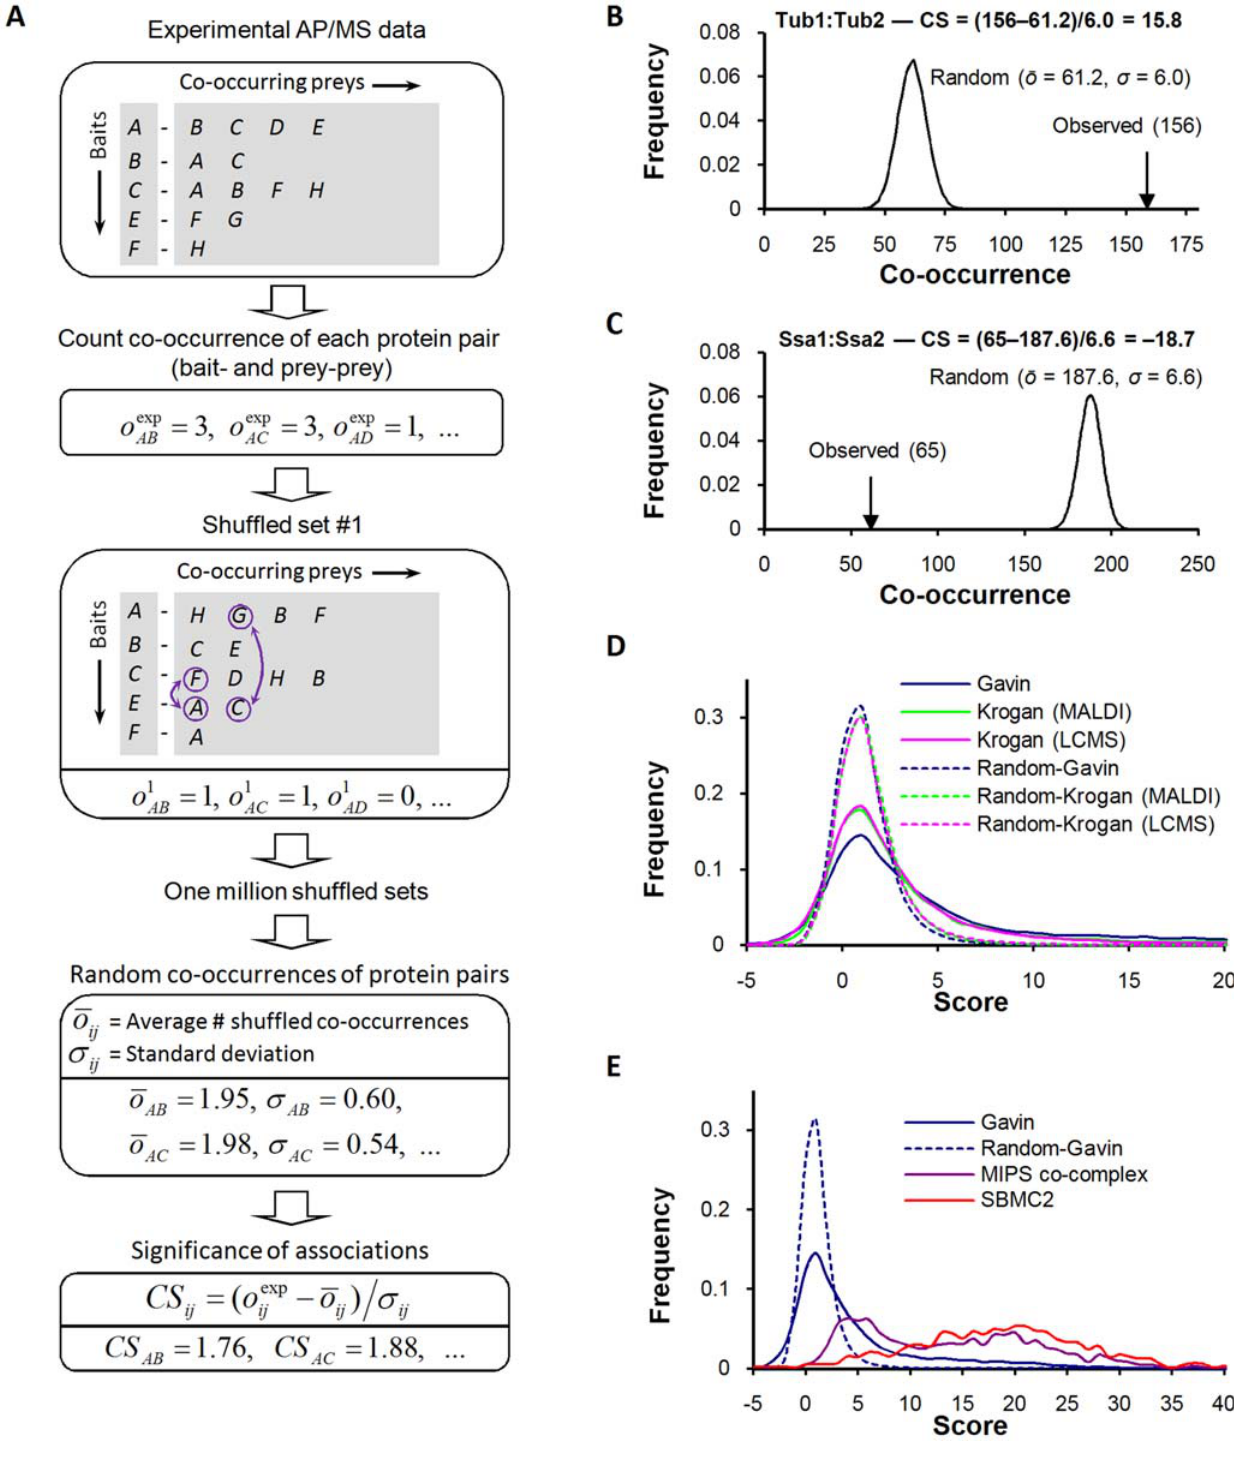
Figure 1. Co-occurrence significance (CS) scores measure the interaction specificity for two proteins in AP/MS data. (A) Flow chart for the computation of CS scores. (B) Illustration for protein pair Tub1:Tub2 showing an overrepresented co-occurrence in the purification data of Gavin et al. [8]: 156 (observed) vs. 61.2 ( s =6.0) (random), with corresponding CS score of 15.8. (C) Illustration for protein pair Ssa1:Ssa2, showing an underrepresented co-occurrence in the purification data of Gavin et al. [8]: 65 (observed) vs. 187.6 ( s =6.6) (random), with corresponding CS score of 2 18.7. (D) Total score distributions of experimental data sets and corresponding average distributions from 10 5 random (shuffled) realizations (see Materials and Methods). (E) score distributions, in purification data of Gavin et al. [8], of selected curated interactions in MIPS [18] and SGD-Biogrid (SBMC2) [23,24] repositories (see Materials and Methods) showing their measured high specificities.